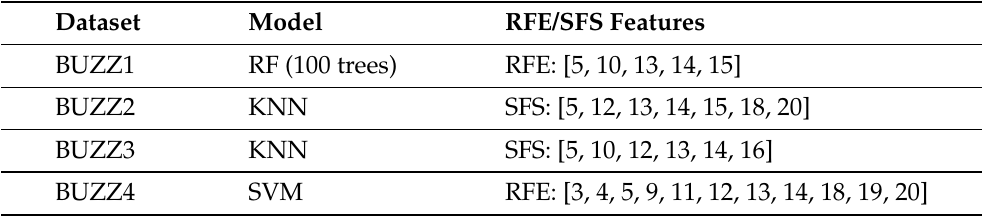
Table 7. SFS-based features for best models on BUZZ1, BUZZ2, BUZZ3, BUZZ4; feature numbers correspond to the indices of the feature array extracted with pyAudioAnalysis library